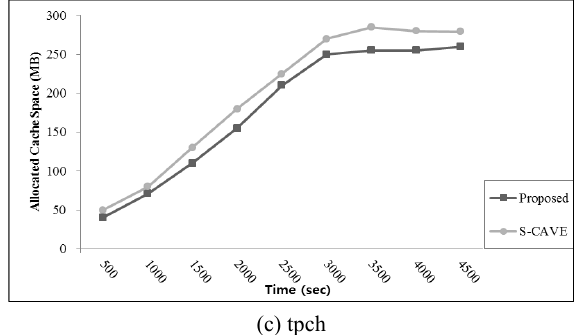
Fig. 9. The comparison of allocated cache with different